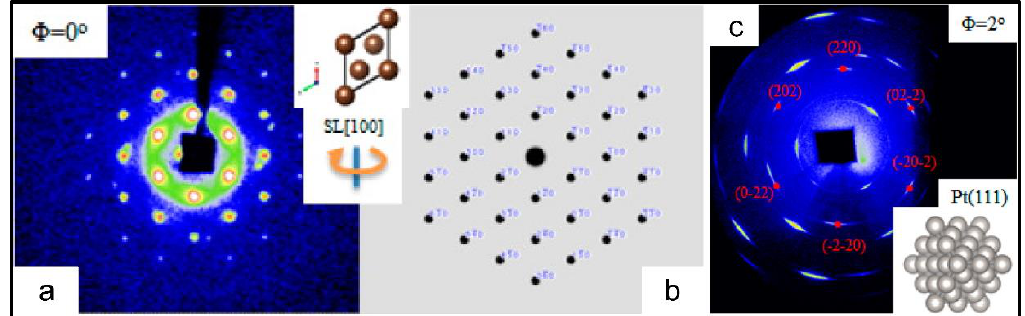
Figure 5. Representative SAXS and WAXS images and as-reconstructed structural details of Pt nanocube-assembled supercrystal at one typical superlattice orientation: ( a ) SAXS image along the SL (111) orientation with ( b ) simulated pattern and ( c ) corresponding WAXS image with atomic Pt (111) orientation of nanocubes. Note: an angular mismatch of 2 degrees exists between superlattice SL (111) and atomic Pt (111) orientation. Copyright of the American Chemical Society [38].